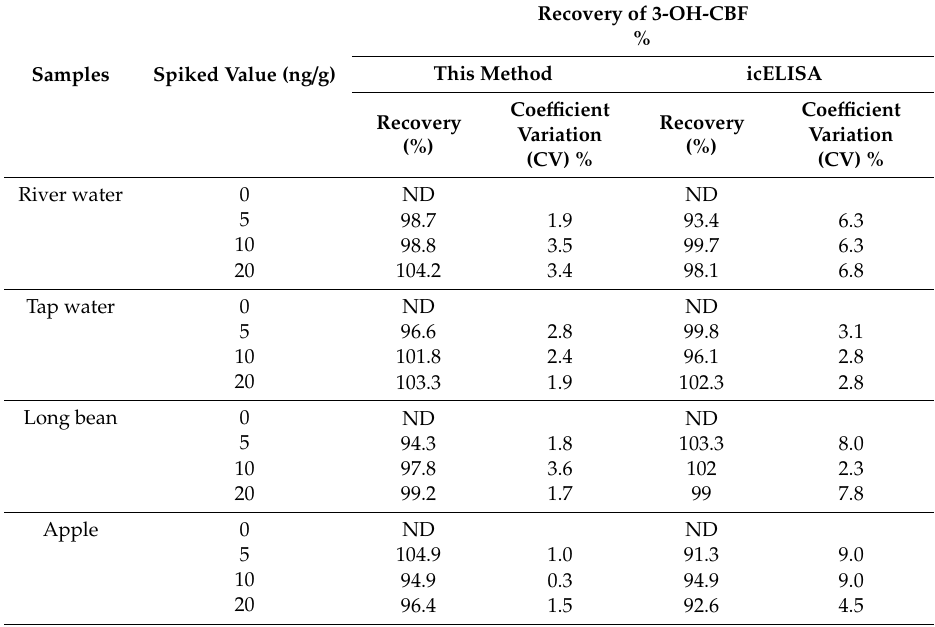
Figure S1: Schematic diagram of the optical waveguide-based fluorescent immunosensor, Figure S2: Schematic diagram of the immobilization of the hapten conjugate 3-succinyl-CBF-OVA on the chip surface, Figure S3: Signal recovery after 20 cycles of measurements and regeneration with 0.5% SDS solution at pH =